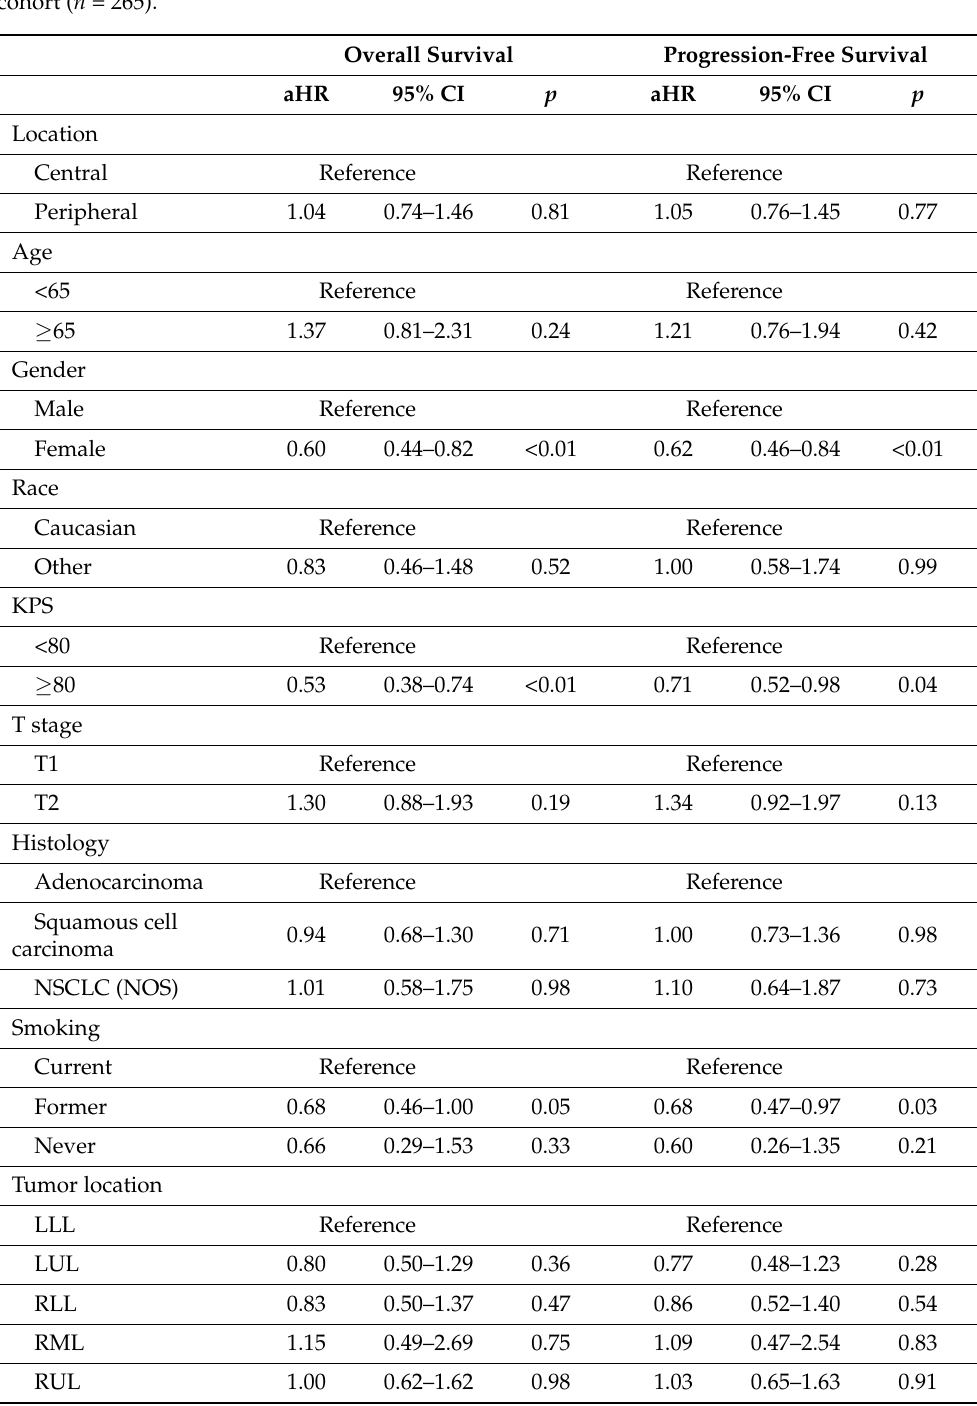
Table 2. Multivariable Cox regression for overall and progression-free survival of the entire patient cohort ( n =